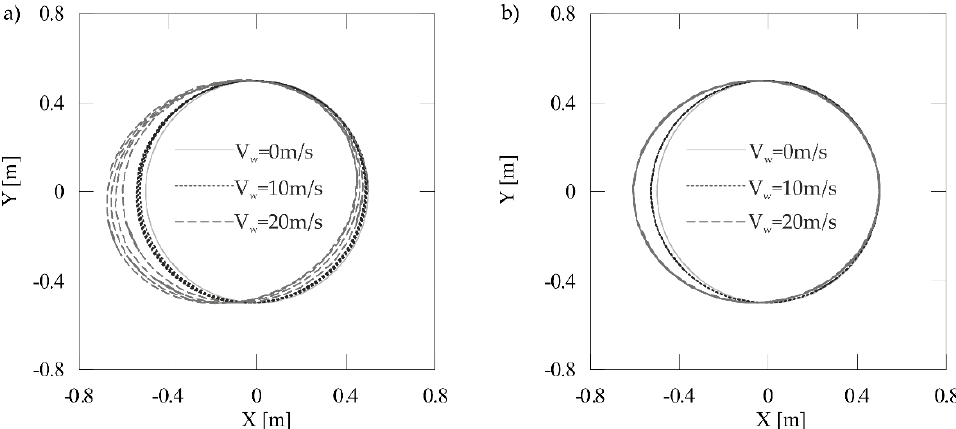
Figure 8. Projection of the trajectory of the carried load’s suspension point on the rotation plane for ( a ) the variable effective area and ( b ) fixed effective area.